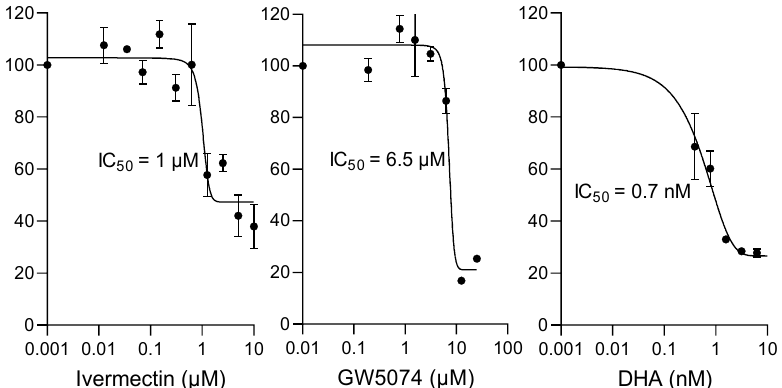
Figure 6. Ivermectin and GW5074 inhibit P. falciparum parasites in culture at low µ M concentrations. P. falciparum cultures (0.25% parasitemia) were treated with increasing concentrations of the indicated compounds for 72 h, after which the HRP2-based sandwich ELISA was used to measure the HRP2 levels, determined by optical density. The results shown are from a single typical experiment performed in duplicate (SD shown), representative of a series of three independent experiments (see Table 5 for pooled data). Table 5. Summary of IC 50 values for inhibition of growth of P. falciparum parasites in culture.